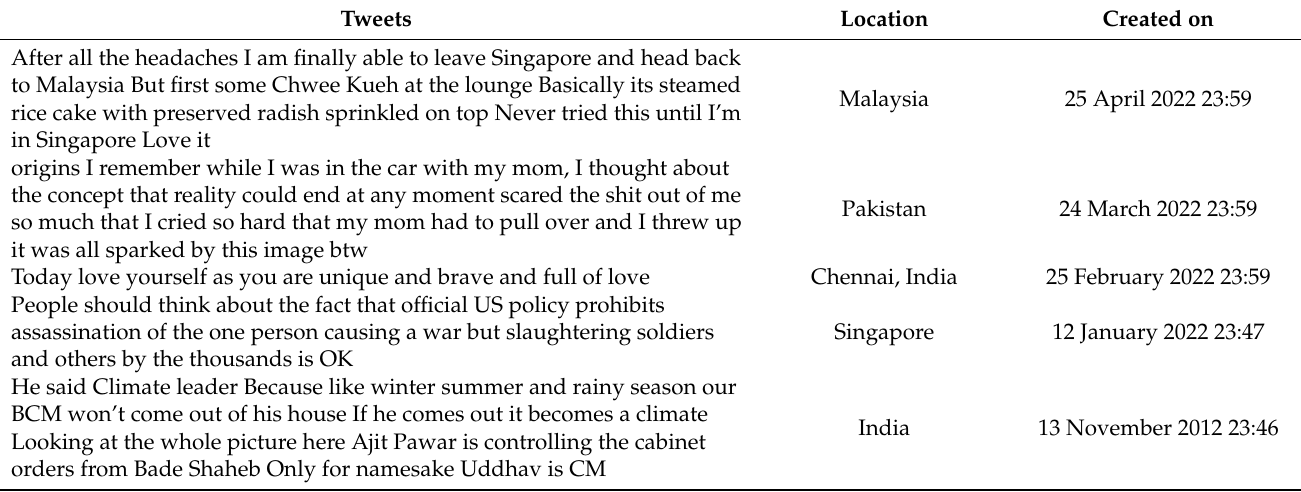
Table 2. Sample datasets with the corresponding location and date. Tweets Location Created on